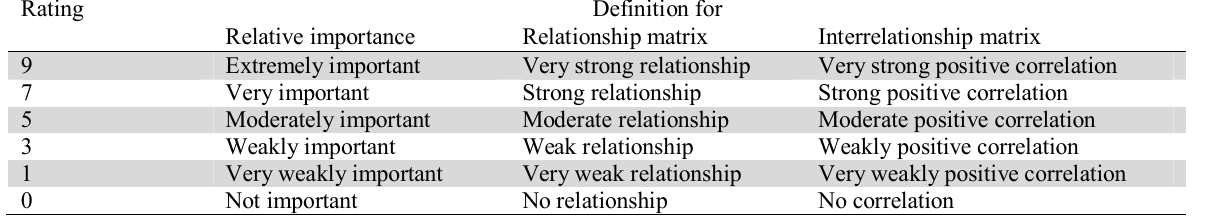
Rating scales for relative importance, relationship and